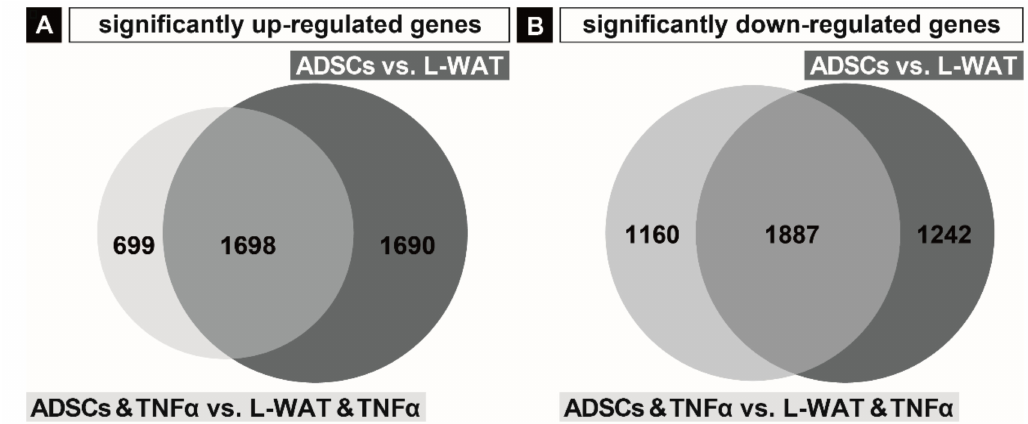
Figure 2. Significantly di ff erentially expressed genes in L-WAT and ADSCs. Significantly upregulated genes in ADSCs compared to L-WAT and in ADSCs and TNF α compared to L-WAT and TNF α ( A ). Significantly, downregulated genes in ADSCs compared to L-WAT and in ADSCs and TNF α compared to L-WAT and TNF α ( B